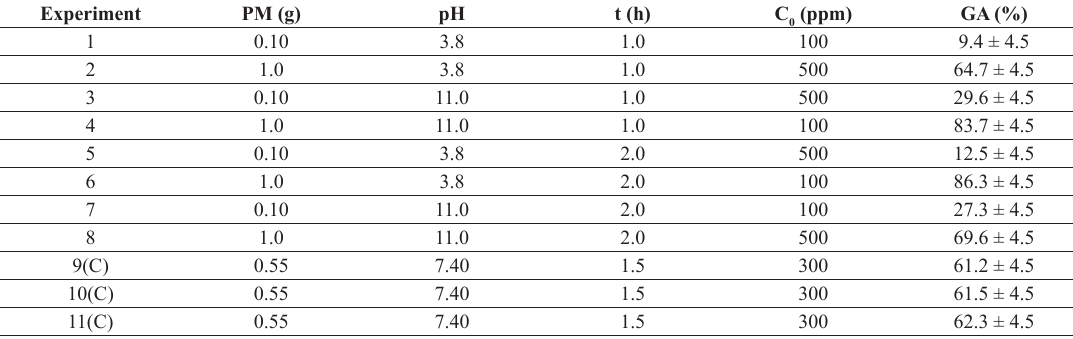
Table 4. Glyphosate adsorption values as a function of palygorskite mass, initial concentration of glyphosate, pH and adsorption test duration. Experiment